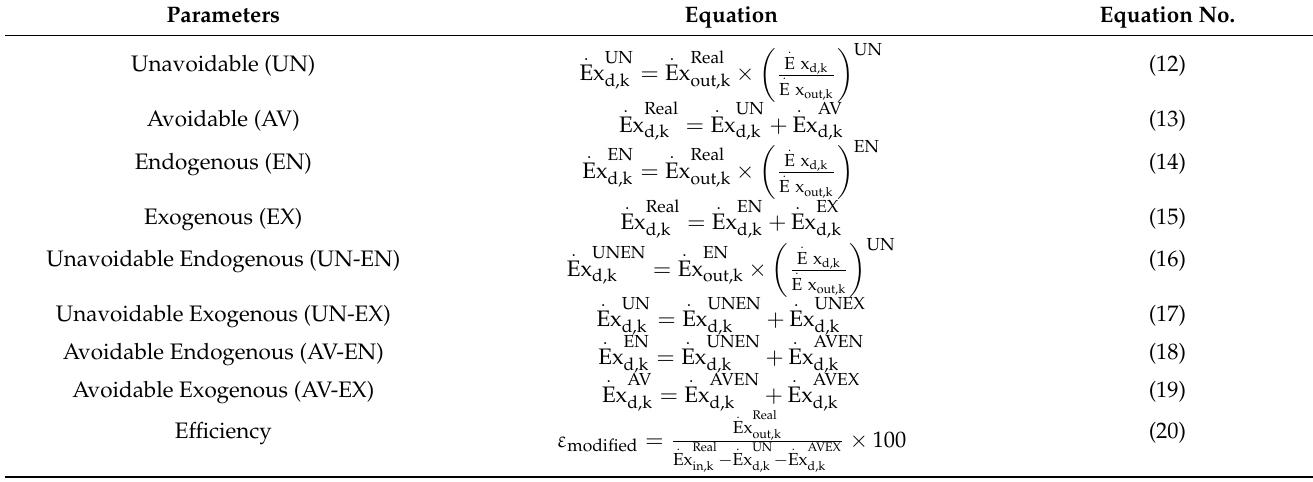
Table 2. Equations used for the calculations of various parameters required to perform advanced exergy